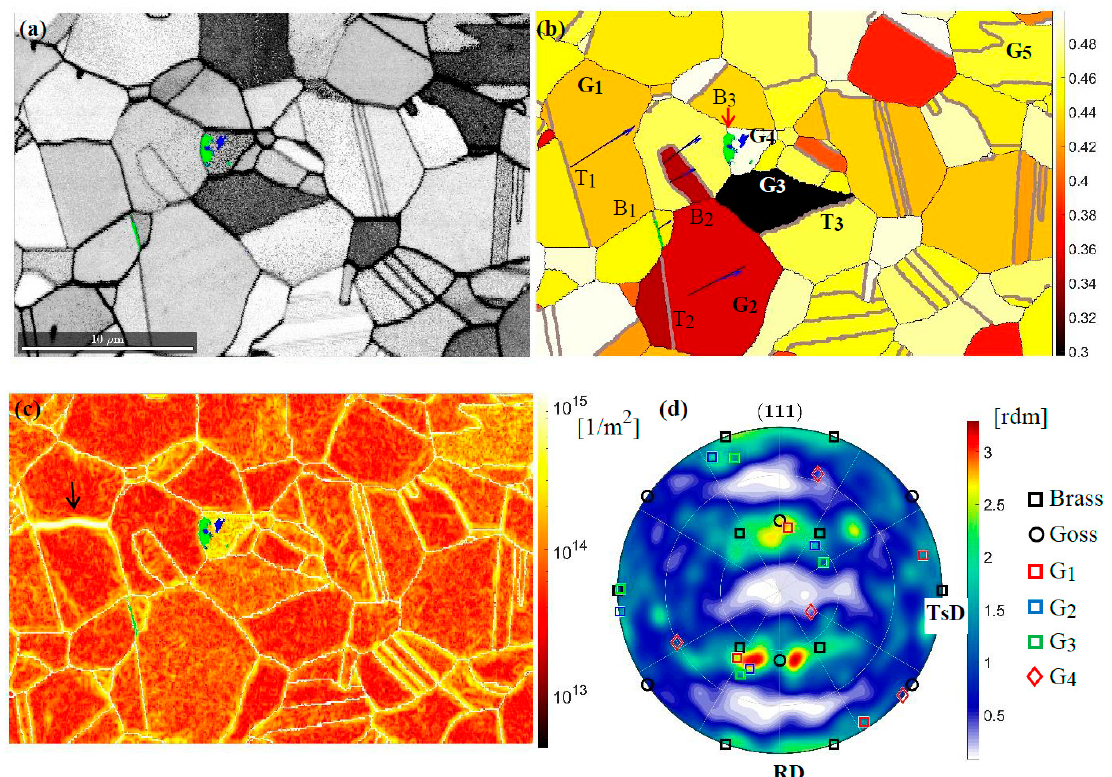
Figure 9. Fragment of the representative area at a distance of 4 mm from the fracture surface. ( a ) Image quality map (IQ) of austenite matrix with arising α ’ martensite (blue) and ε martensite (green). ( b ) Map of maximal Schmid factors with corresponding traces of slip planes and slip directions, twin boundaries are denoted by thick grey lines. ( c ) Dislocation density distribution, the arrow indicates the band of strain localisation. ( d ) {1 1 1} pole figure for the entire representative area.